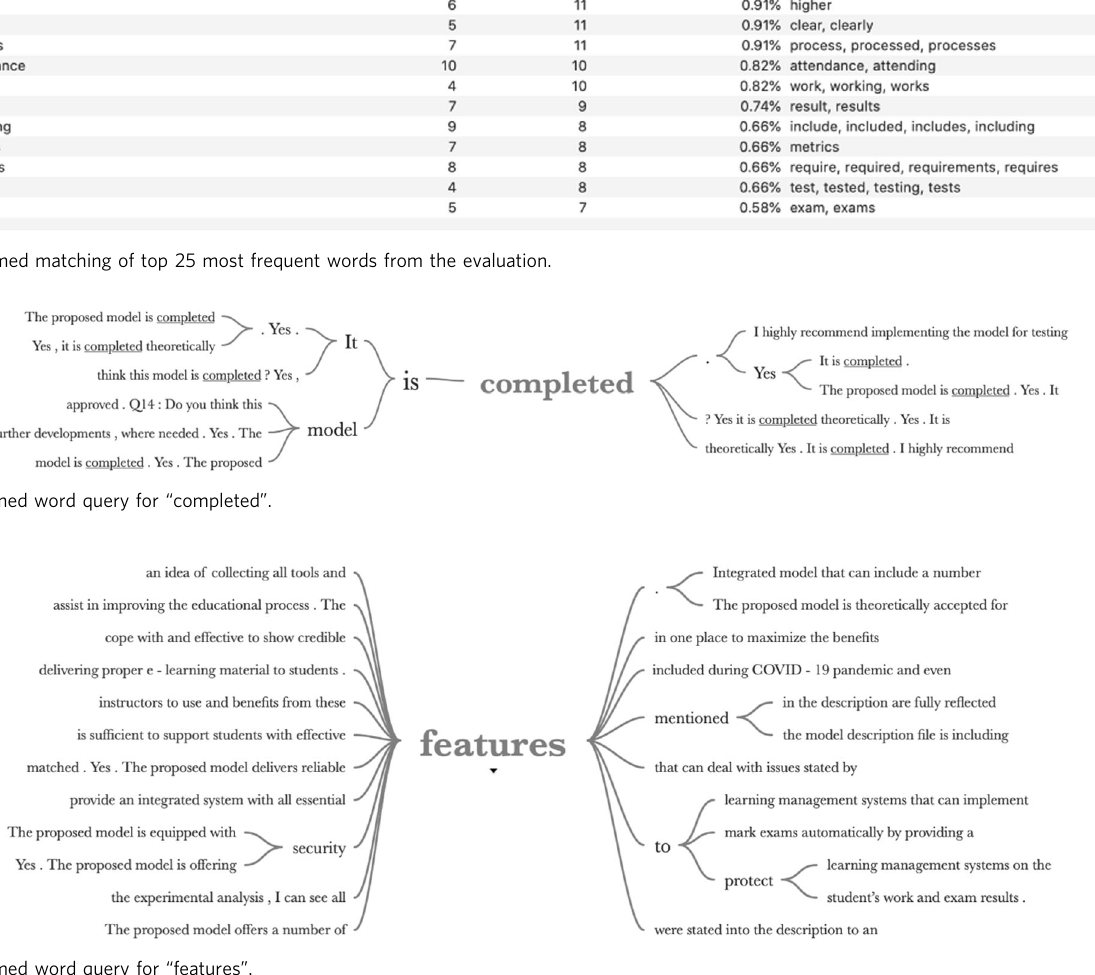
Fig. 6 Stemmed word query for “ features ”